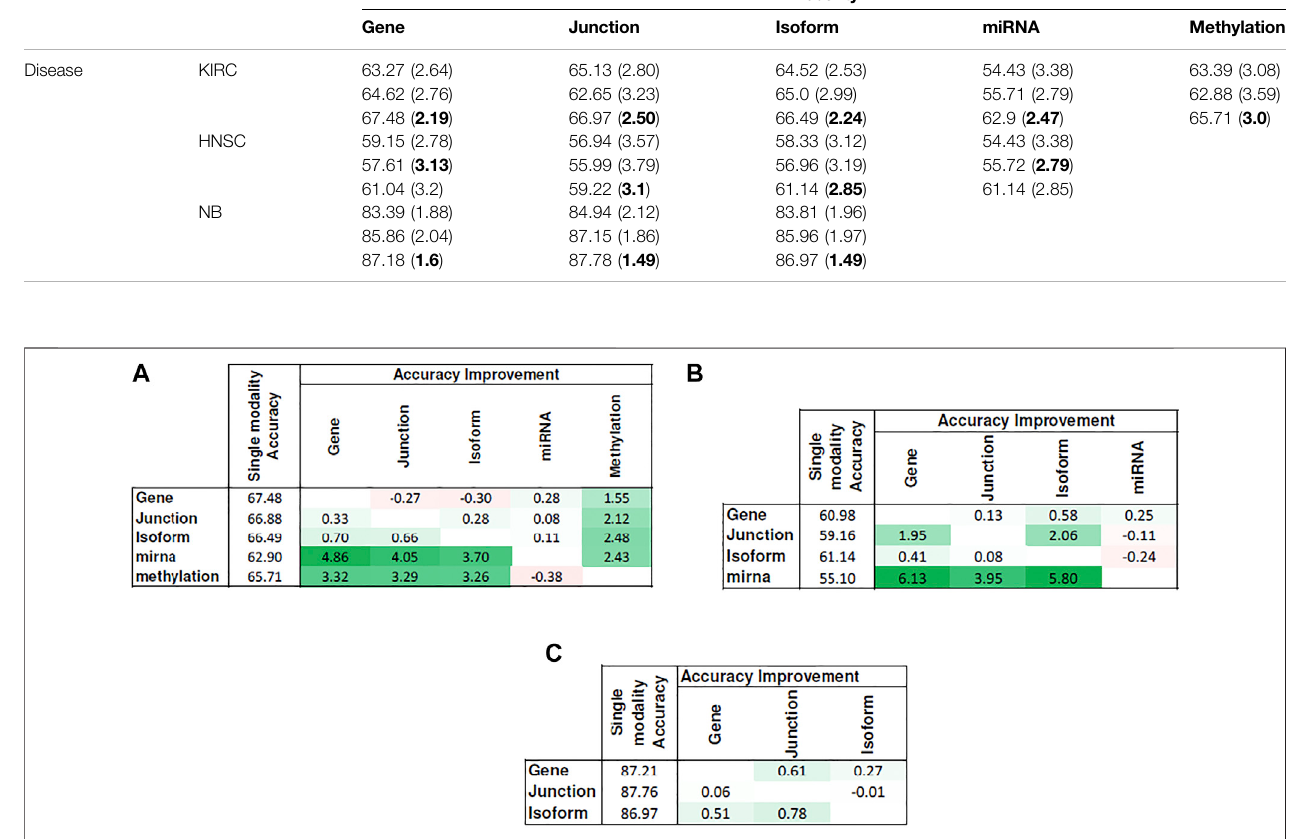
FIGURE5 | Improvementachievedafterintegratingpairsofmodalities.Columnsshowtheadditionalmodalityaddedtothesingle-modalitymodel(denotedbyrows).Cellvalues show the difference in accuracy between the integrated model and the single-modality model. Tables (A) – (C) correspond to KIRC, HNSC, and NB,